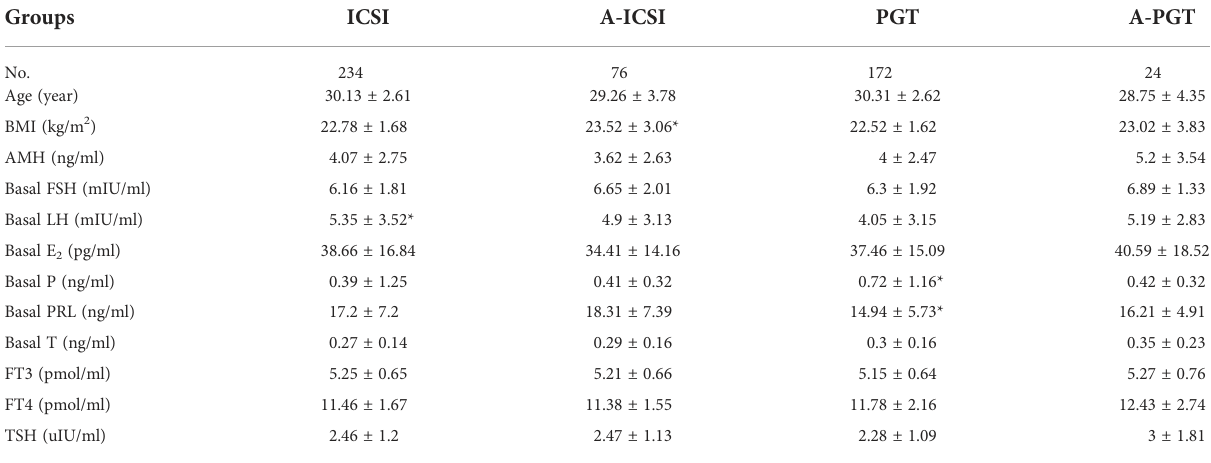
TABLE 1 Comparison of the general clinical characteristics of patients in the four groups.